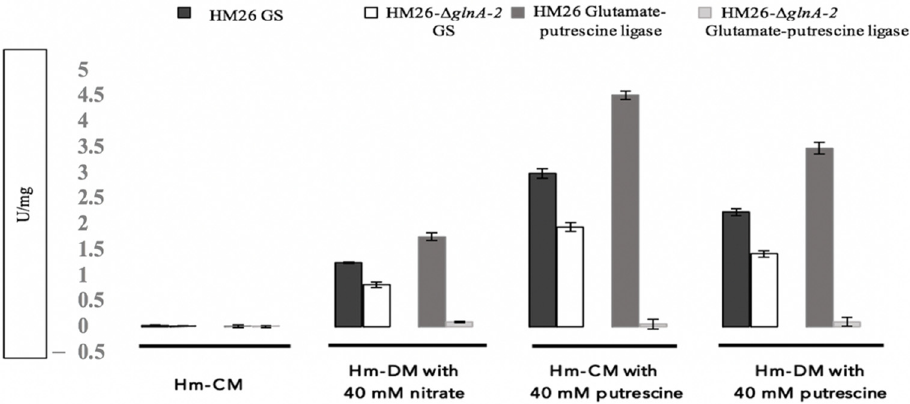
Figure 7. Comparison of GS and glutamate–putrescine ligase activities between Hfx. mediterranei parental strain (HM26) and mutant strain (HM26- ∆ glnA-2 ), according to the nitrogen source.